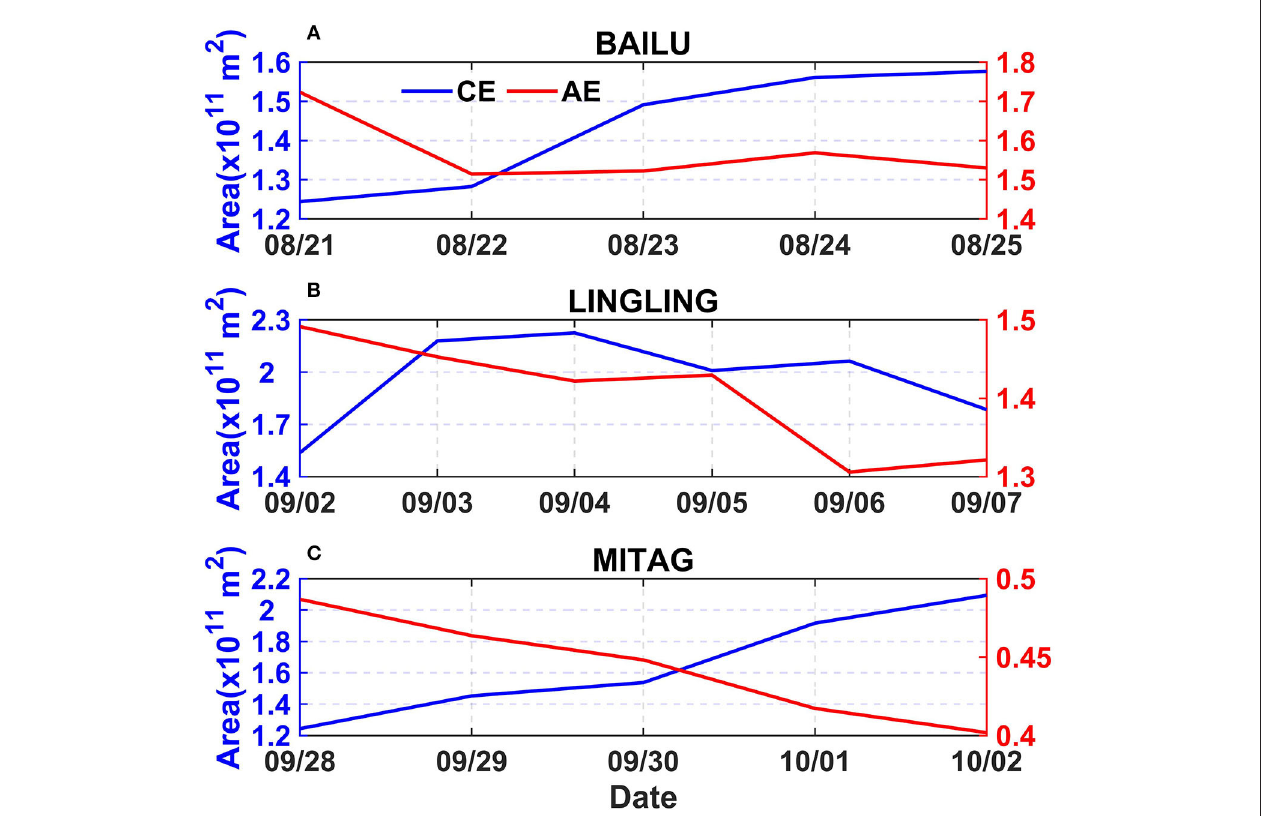
FIGURE 10 | The change of eddies size near the wave glider during TCs (A) Bailu, (B) Lingling, and (C) Mitag. The red and blue lines are for the warm eddy and cold eddy, respectively. To elucidate the cold area more concisely, the size is calculated as the area where sea-level anomaly < 0cm and > 0cm for cold eddy and warm eddy, respectively. TCs, tropical